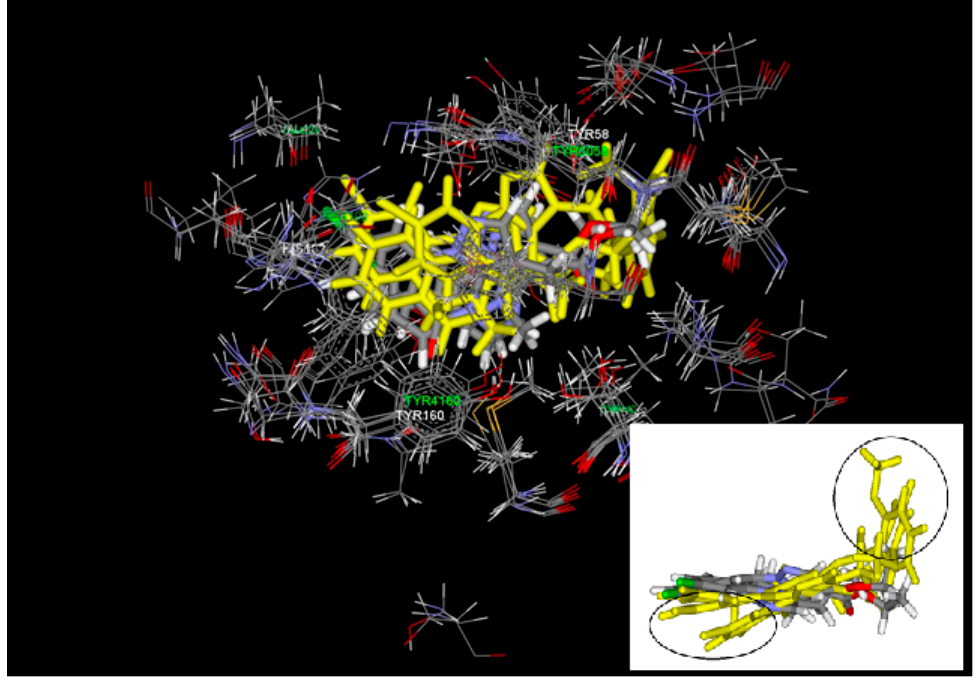
Figure 1. Superimposition of antagonists (colored by element) and agonists (yellow). The black circles evidence the different areas occupied by agonists.